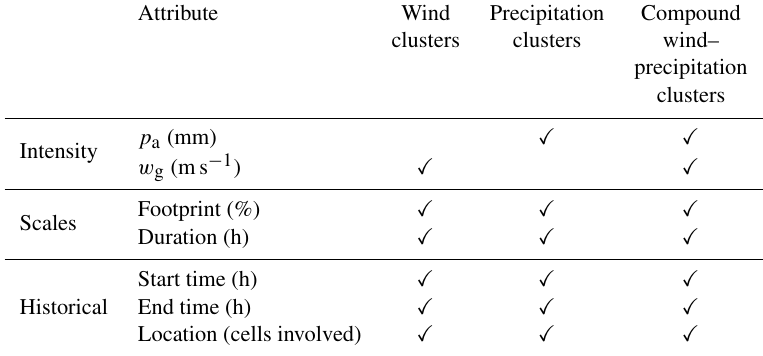
Table 1. Intensity and spatiotemporal attributes of hazard clusters and their availability for wind, precipitation, and compound hazard events in the present